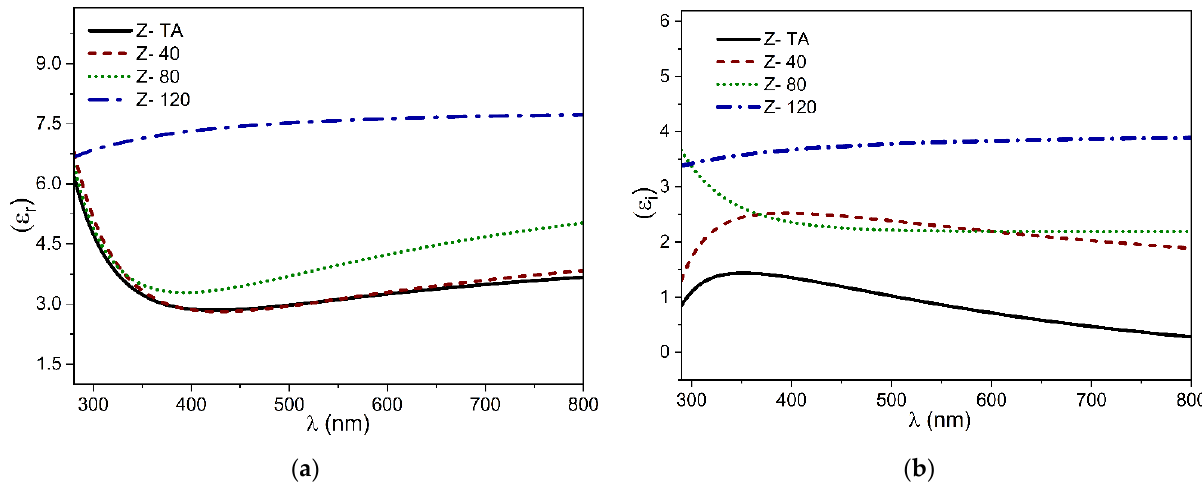
Figure 6. The dispersion curves of dielectric constants plotted in ( a ) the real part ε r and ( b ) the imaginary part ε i .